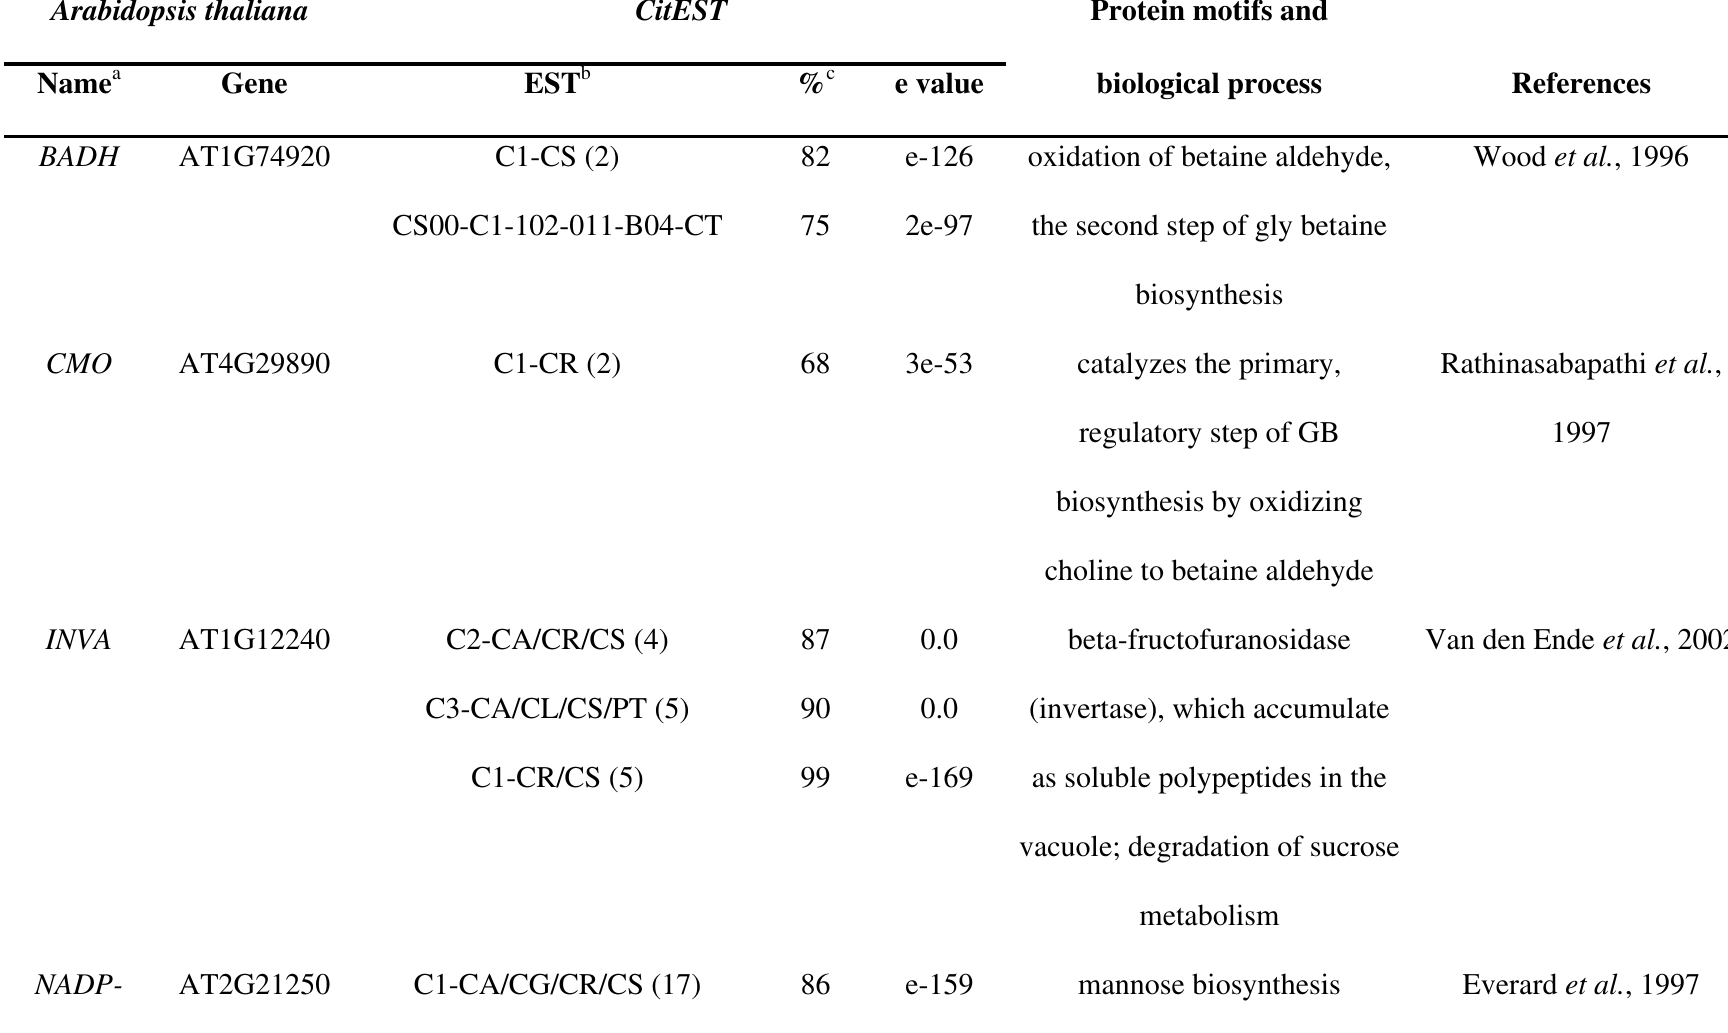
Table S3 –Citrus ESTs with homology to genes involved in osmolyte